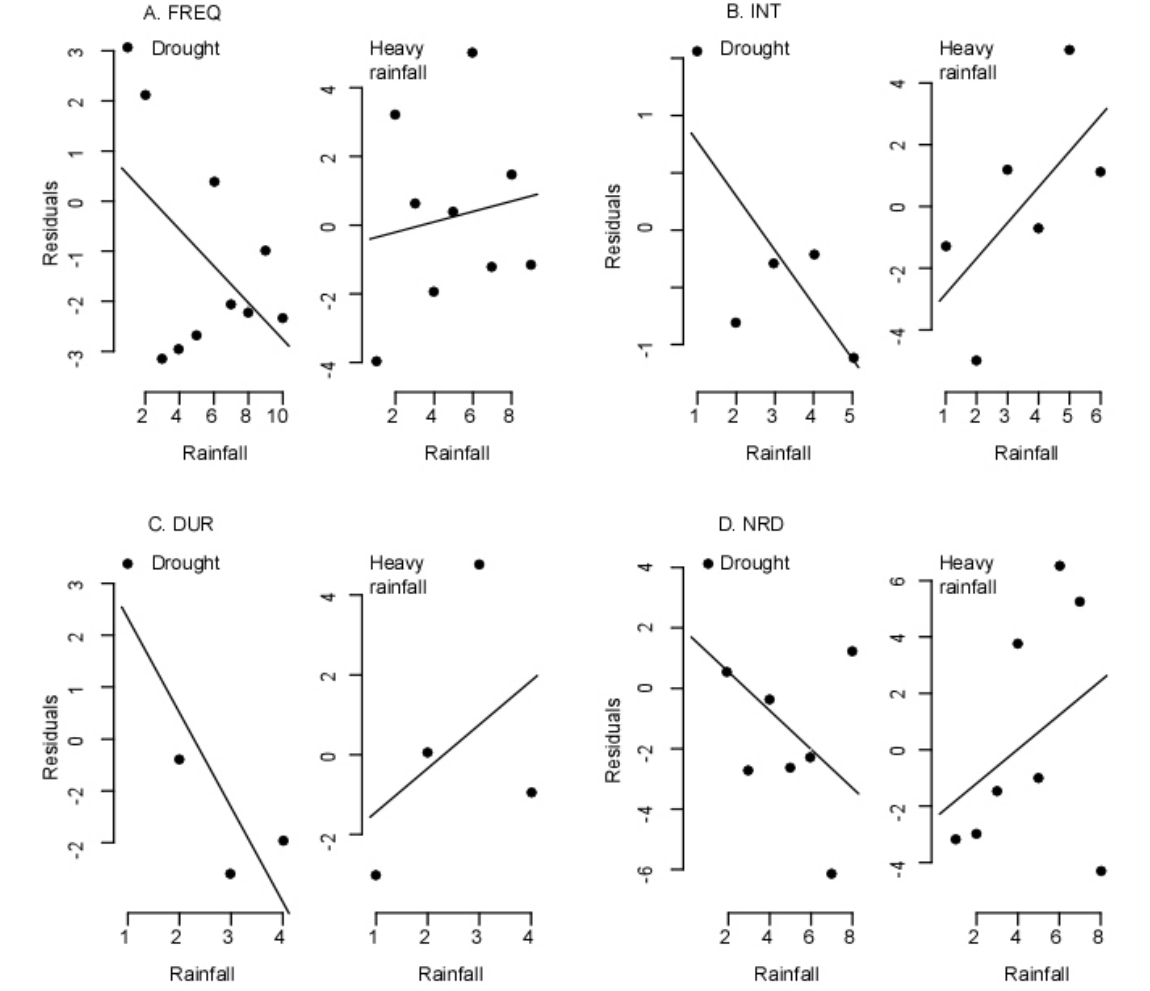
Fig. 4 . Proportion of farmers relating varietal losses to past climatic accidents, as a function of rainfall categories. Pearson's residuals are presented as a function of rainfall categories in ascending order. A. Frequency of rainy days - FREQ; B. Rainfall intensity - INT; C. Seasonal duration - DUR; D. Number of rainy days –